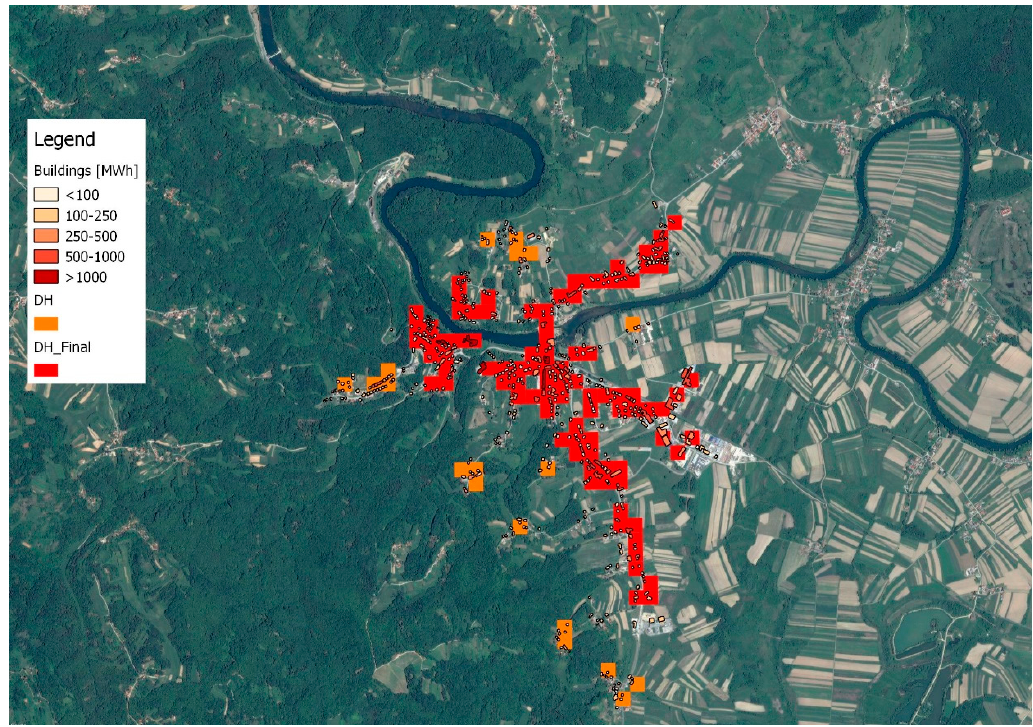
Figure 3. Parts of the city for which it is feasible to establish a connection to a district heating system (orange) and final area selection used in further analyses (red). Table 3. Different excess heat prices, costs of pipes, and available excess heat supply used in the analysis of excess heat